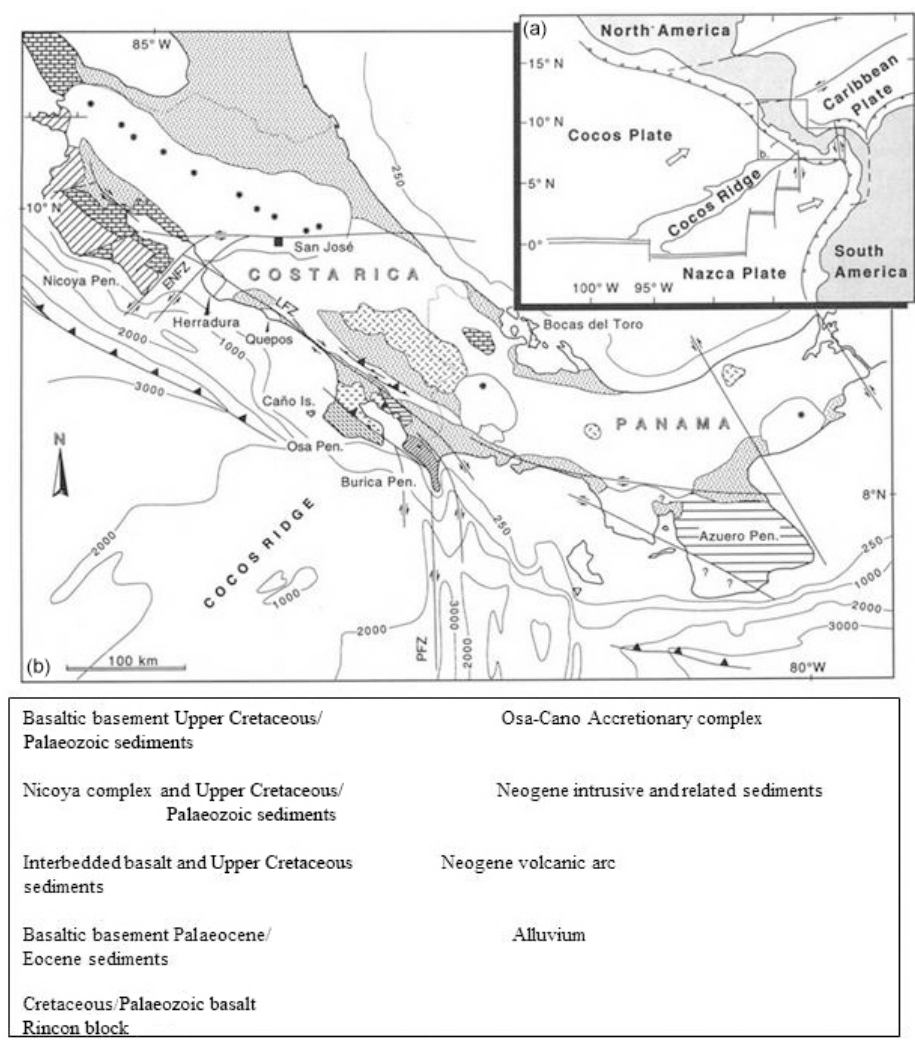
Figure 1. Geological and tectonic map of the Costa Rica convergent margin, Central America (modified after Case and Holcambe,